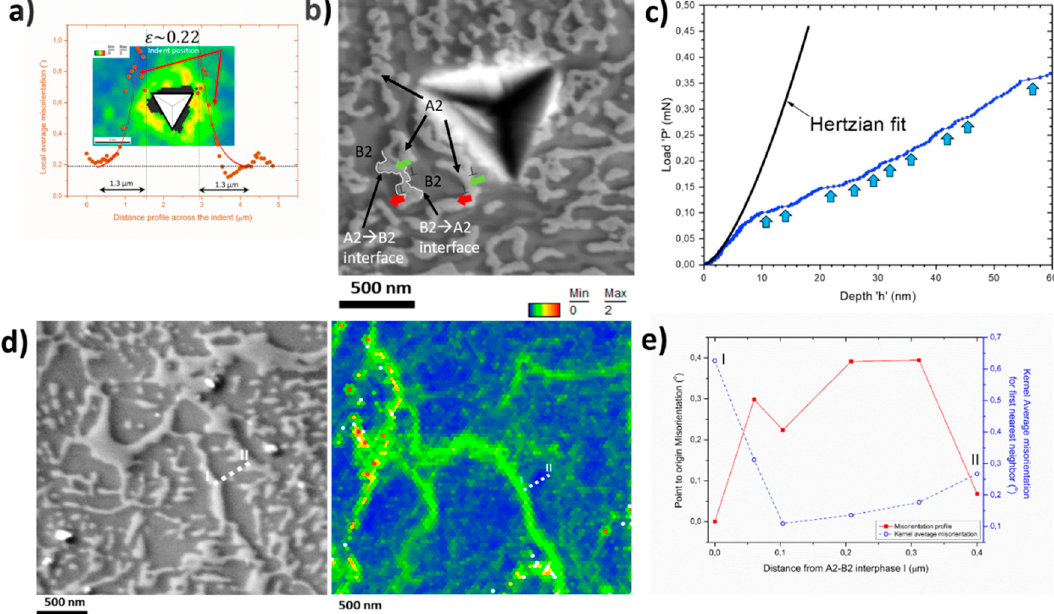
Figure 1. ( a ) Indent strain profile and ( b ) corresponding microstructure showing the dislocation motion across an A2/B2 interface. Dislocations experience strengthening when moving from the A2 to the ordered B2 phase, owing to spinodal and order hardening effects. The corresponding jerky dislocation motion is highlighted in nano-indentation load-displacement curves in ( c ). ( d ) shows the strain distribution with bright A2 phases being more plastic than the elastically stiffer dark B2 phase. ( e ) Corresponding misorientation profile and kernel average misorientation gradient on moving away from the interphase into the B2 phase. Figure 1d,e was adapted from [16] with permission from Elsevier, 2018.